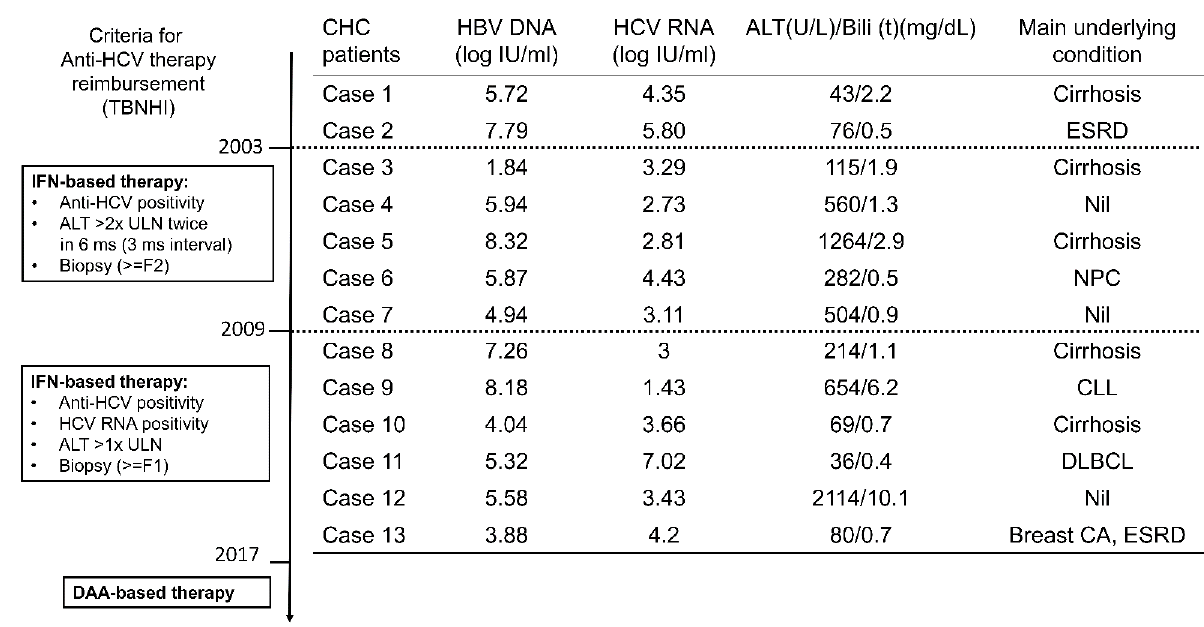
Figure 1. The anti-HCV therapy reimbursement policy of the Taiwan Bureau of National Health Insurance (TBNHI) and the baseline characteristics of the 13 CHB patients with CHC. IFN: interferon; ULN: upper limit of normal; ms: months; F1: fibrosis score 1; F2: fibrosis score 2; ESRD: end- stage renal disease (both patients with ESRD had undergone hemodialysis); NPC: nasopharyngeal carcinoma; CLL: chronic lymphocytic leukemia; DLBCL: diffuse large B-cell lymphoma; Nil: nothing; CA: cancer. Case 13 received the DAA therapy in 2019 and acquired an SVR after the therapy.